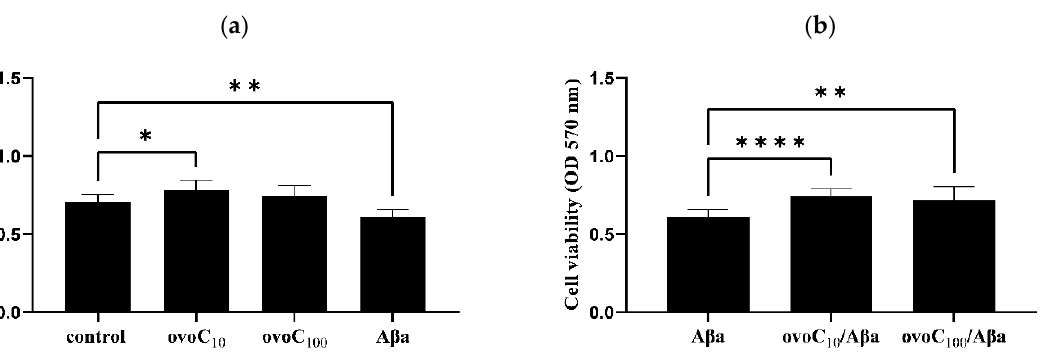
Figure 6. Viability of PC12 cells treated with A β 1 − 40 (20 µM) alone ( a ) or with different concentra- tions of ovoC ( b ) for 24 h. Cell viability was measured with MTT assays and is shown as a percentage of the untreated cells (control). Data were analyzed by one-way ANOVA to evaluate treatment effect. * p ≤ 0.038 and ** p ≤ 0.002 when compared with control cells. **** p ≤ 0.0001 and ** p ≤ 0.01 when compared with A β 42 alone.